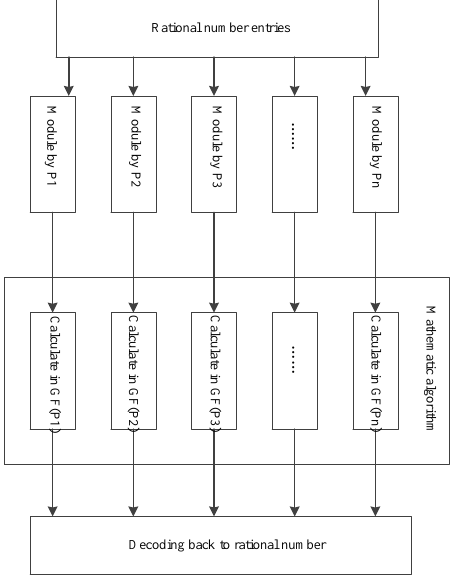
Fig. 1. Extend CRT parallel implementation chart But in practice, there is a disadvantage of